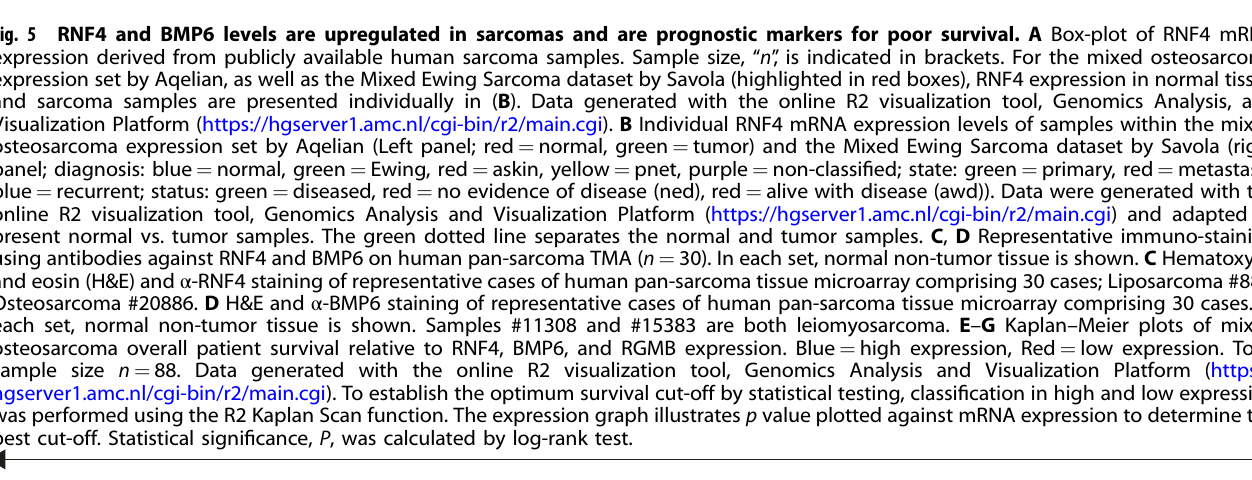
Fig. 5 RNF4 and BMP6 levels are upregulated in sarcomas and are prognostic markers for poor survival. A Box-plot of RNF4 mRNA expression derived from publicly available human sarcoma samples. Sample size, “ n ” , is indicated in brackets. For the mixed osteosarcoma expression set by Aqelian, as well as the Mixed Ewing Sarcoma dataset by Savola (highlighted in red boxes), RNF4 expression in normal tissue and sarcoma samples are presented individually in ( B ). Data generated with the online R2 visualization tool, Genomics Analysis, and Visualization Platform (https://hgserver1.amc.nl/cgi-bin/r2/main.cgi). B Individual RNF4 mRNA expression levels of samples within the mixed osteosarcoma expression set by Aqelian (Left panel; red = normal, green = tumor) and the Mixed Ewing Sarcoma dataset by Savola (right panel; diagnosis: blue = normal, green = Ewing, red = askin, yellow = pnet, purple = non-classi fi ed; state: green = primary, red = metastasis, blue = recurrent; status: green = diseased, red = no evidence of disease (ned), red = alive with disease (awd)). Data were generated with the online R2 visualization tool, Genomics Analysis and Visualization Platform (https://hgserver1.amc.nl/cgi-bin/r2/main.cgi) and adapted to present normal vs. tumor samples. The green dotted line separates the normal and tumor samples. C , D Representative immuno-staining using antibodies against RNF4 and BMP6 on human pan-sarcoma TMA ( n = 30). In each set, normal non-tumor tissue is shown. C Hematoxylin and eosin (H&E) and α -RNF4 staining of representative cases of human pan-sarcoma tissue microarray comprising 30 cases; Liposarcoma #884; Osteosarcoma #20886. D H&E and α -BMP6 staining of representative cases of human pan-sarcoma tissue microarray comprising 30 cases. In each set, normal non-tumor tissue is shown. Samples #11308 and #15383 are both leiomyosarcoma. E – G Kaplan – Meier plots of mixed osteosarcoma overall patient survival relative to RNF4, BMP6, and RGMB expression. Blue = high expression, Red = low expression. Total sample size n = 88. Data generated with the online R2 visualization tool, Genomics Analysis and Visualization Platform (https:// hgserver1.amc.nl/cgi-bin/r2/main.cgi). To establish the optimum survival cut-off by statistical testing, classi fi cation in high and low expression was performed using the R2 Kaplan Scan function. The expression graph illustrates p value plotted against mRNA expression to determine the best cut-off. Statistical signi fi cance, P , was calculated by log-rank